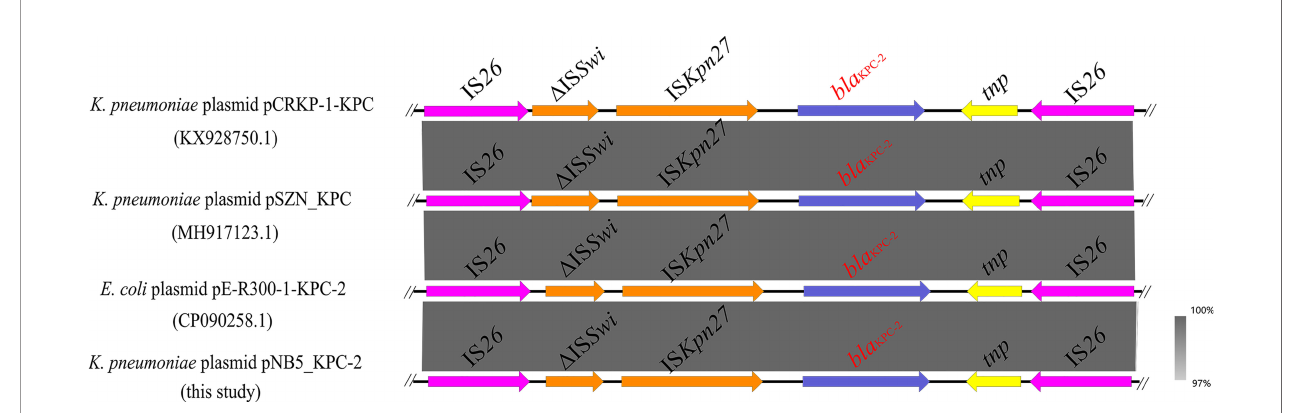
FIGURE 4 | Genetic context of bla KPC-2 located on K. pneumoniae strain NB5 plasmid pNB5_KPC-2 compared with other similar sequences. The blue arrows indicate the bla KPC-2